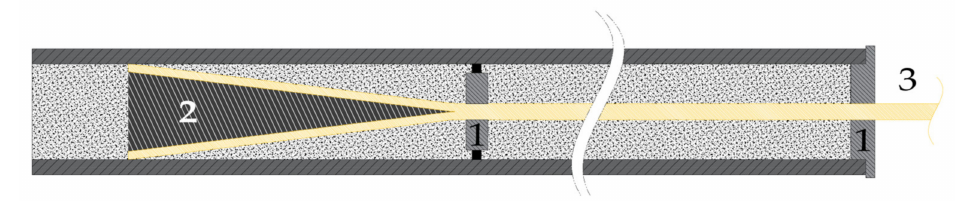
Figure 8. Spike anchorage proposed by Arnautov et al. [21]. In detail: 1—centering rings; 2—duralumin wedges; 3—rod. Starting from the previous configuration (denoted as full-adhesion contact), two variants have been proposed by treating with polyvinyl alcohol: (1) all the rod surface (full- friction contact) or (2) only the straight part, excluding the wedged part (adhesion-friction contact). Adopting a traditional (not wedged) anchorage (with epoxy), the pull-out